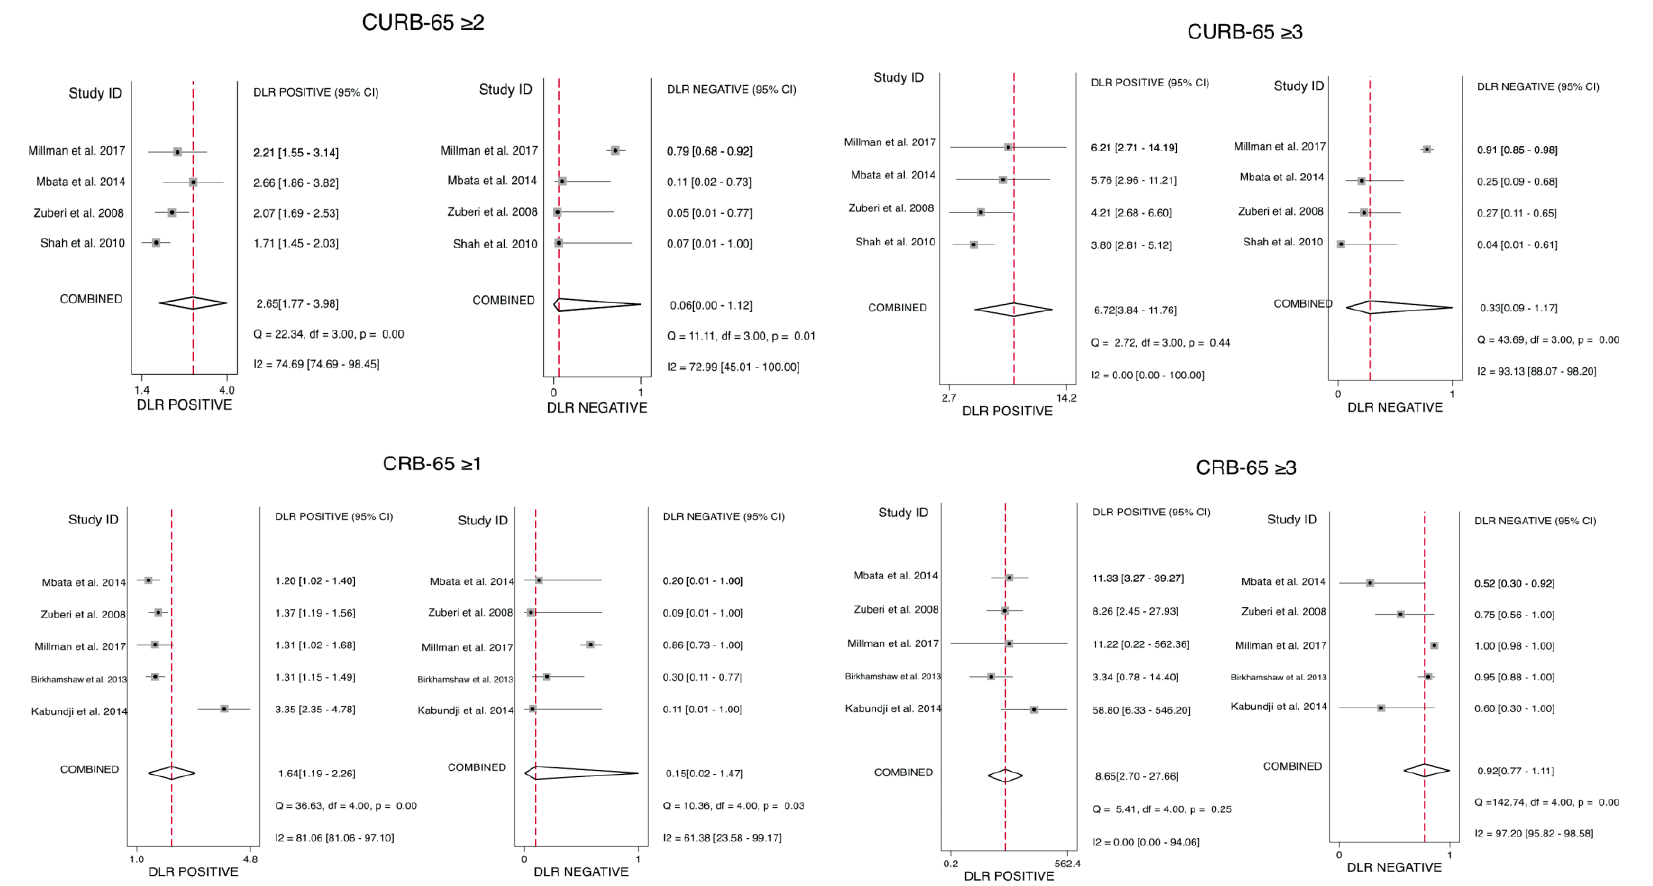
Figure 4. Forest plots for the positive and negative likelihood ratio of CURB-65 and CRB-65 at the studied cut-offs for mortality prediction.